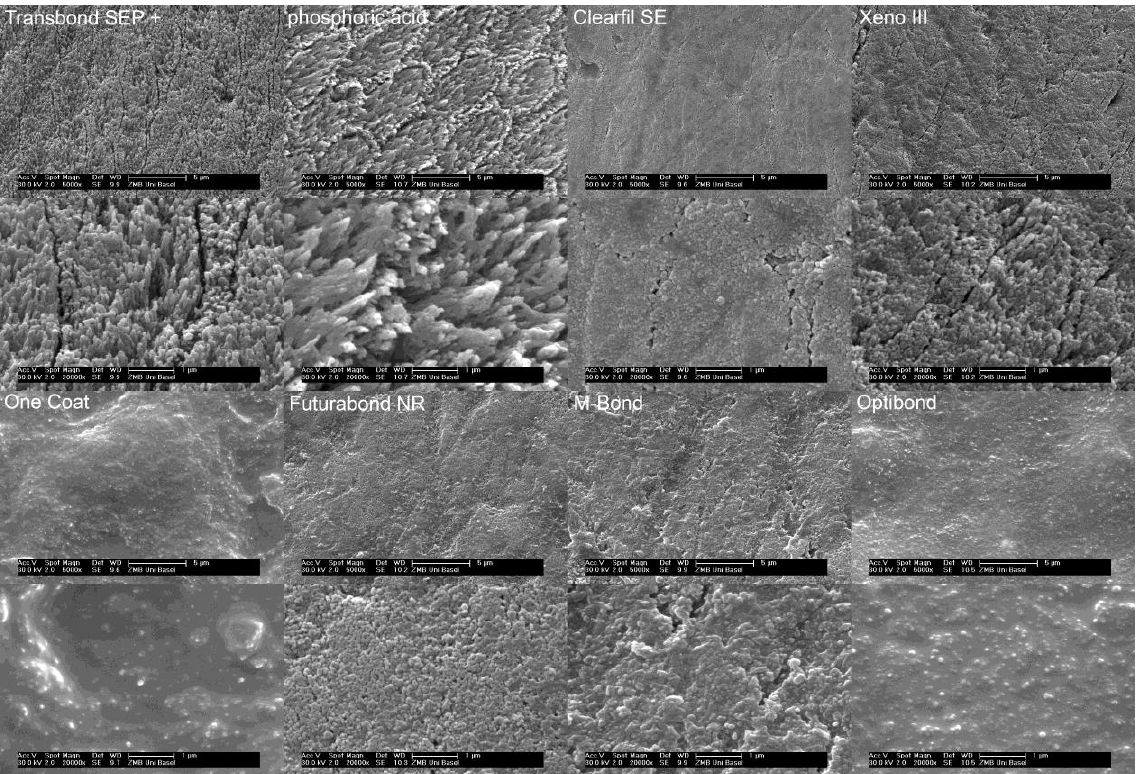
Figure 2. Representative SEM images of all investigated products. Macroscopic etching patterns are shown with the product name. The corresponding microscopic etching patterns of each product are shown right below the macroscopic SEM images.